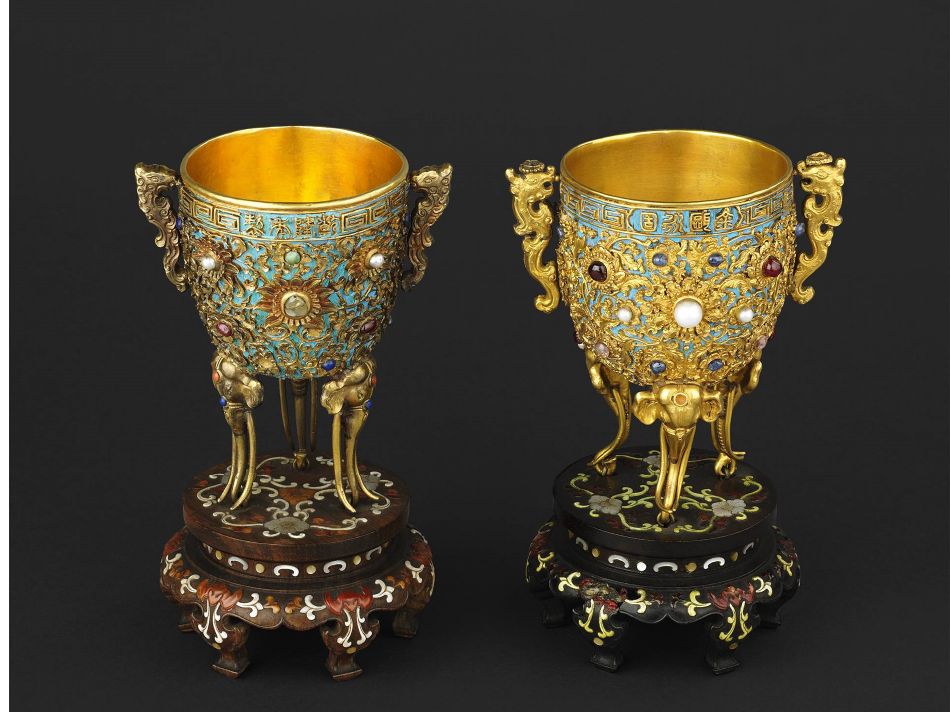
Figure 9. Gold cups of eternal stability, probably 1739–1740 and 1740–1741, Beijing, China. Wallace Collection, London. Photo: Wallace Collection.